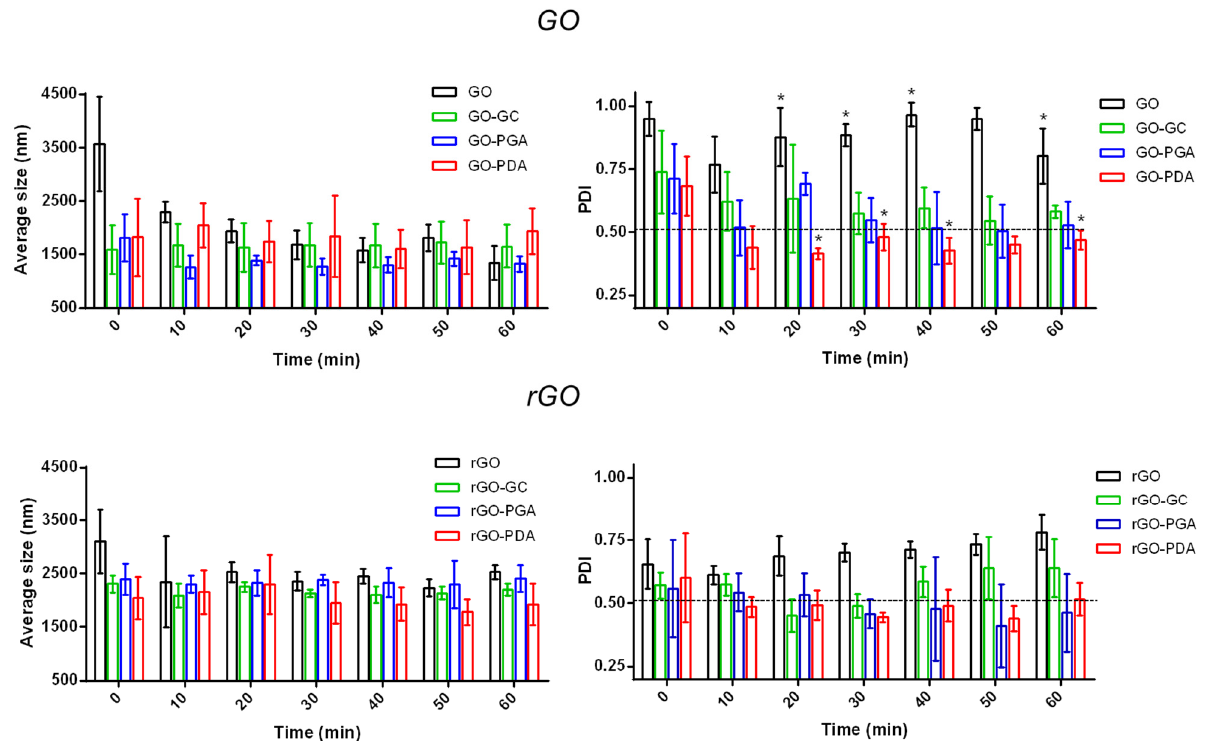
Figure 3. Dynamic light scattering analysis of GO ( top ) and rGO ( bottom ) samples (with and without coatings) in terms of average size (left) and polydispersity index (PDI, right). The dashed line represents a maximum “acceptance threshold” set at 0.5 [15] for the PDI. GO, uncoated graphene oxide (control); GO-GC, graphene oxide coated with glycol chitosan; GO-PGA, graphene oxide coated with propylene glycol alginate; GO-PDA, graphene oxide functionalized with polydopamine; rGO, uncoated reduced graphene oxide (control); rGO-GC, reduced graphene oxide coated with glycol chitosan; rGO-PGA, reduced graphene oxide coated with propylene glycol alginate; rGO-PDA, reduced graphene oxide functionalized with polydopamine. N = 3. * = p -value < 0.05.